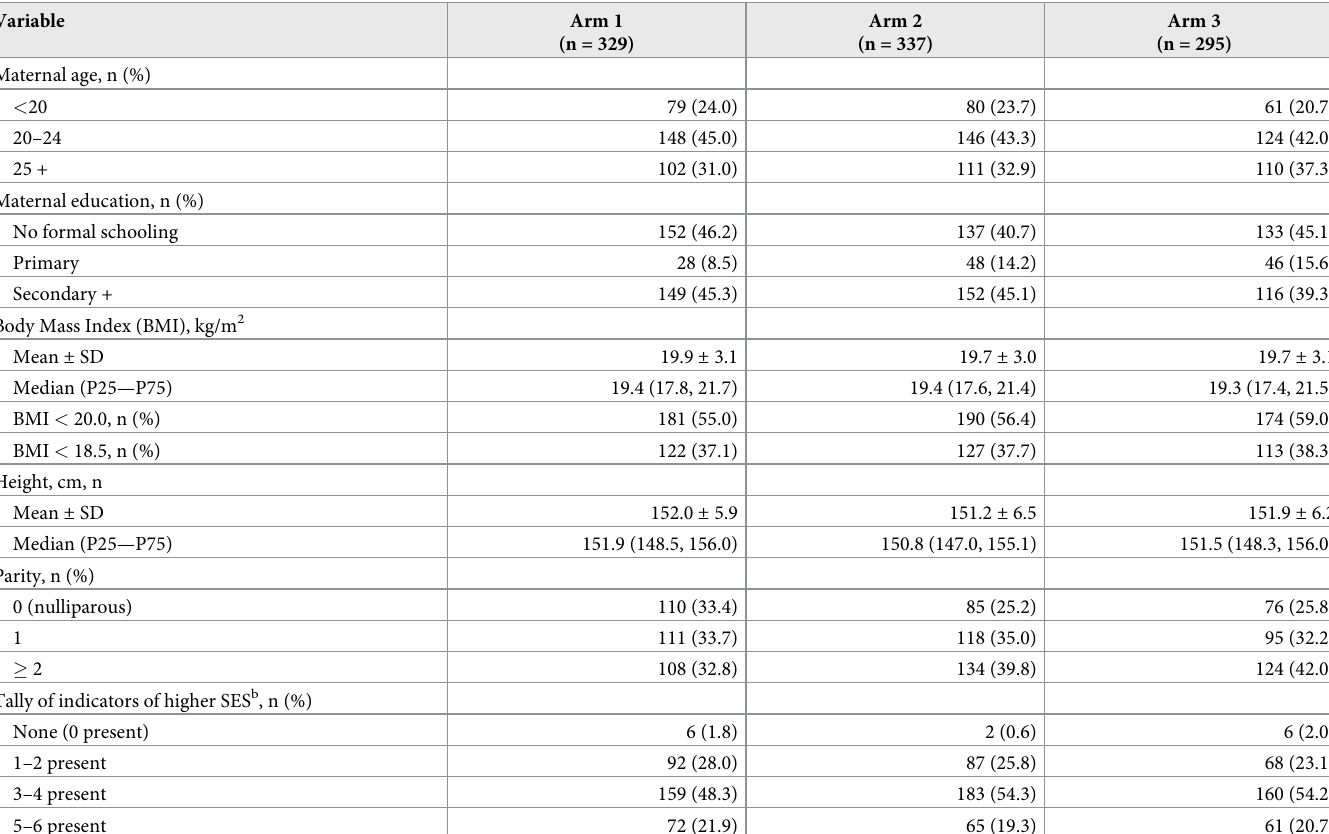
Table 1. Overall baseline characteristics among women in South Asian study sites who had the primary outcome and gestational age available for newborns by treatment arm a